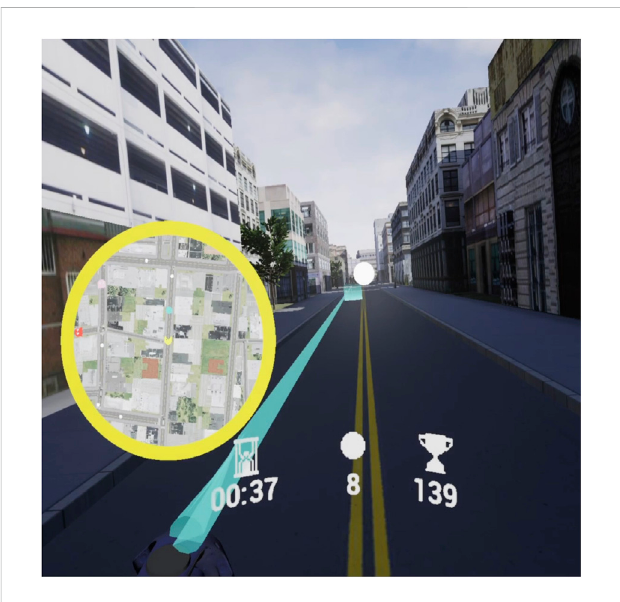
FIGURE 3 A screenshot of the implemented Mini-Map